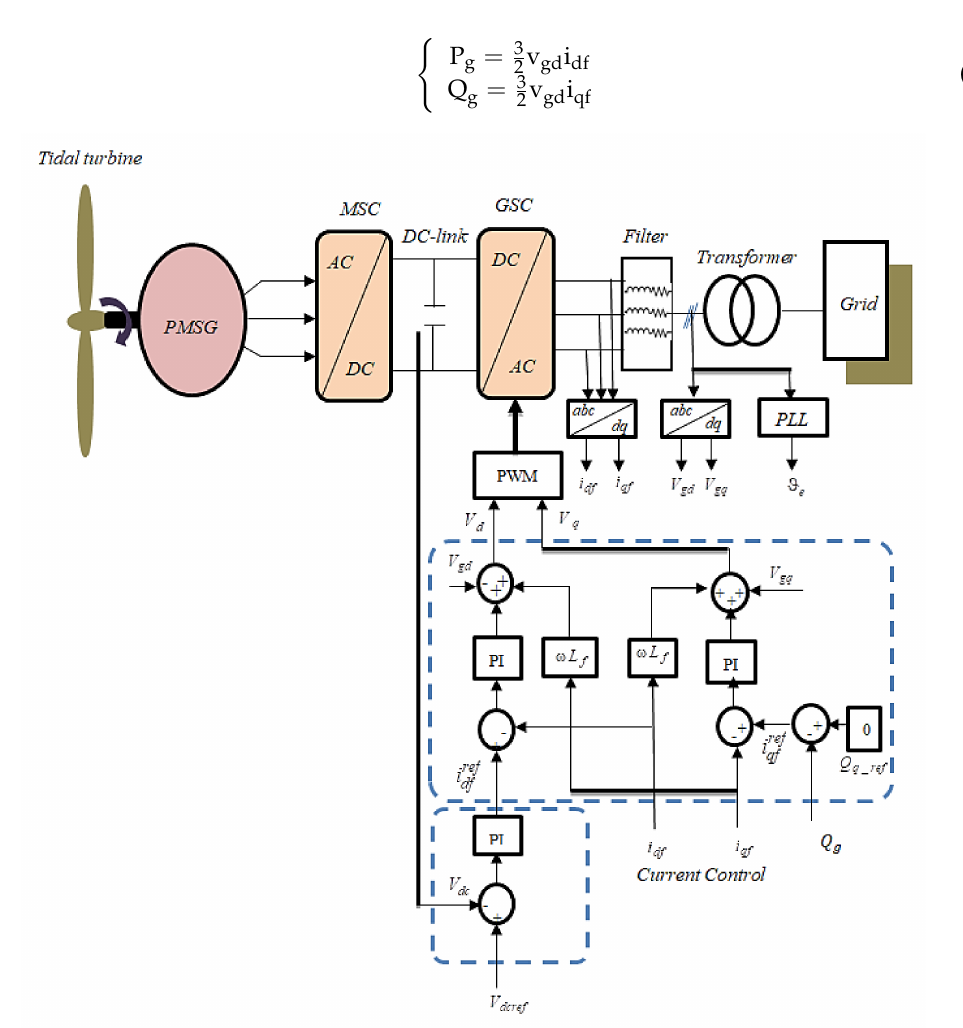
Figure 6. Grid-side converter (GSC) PI controller